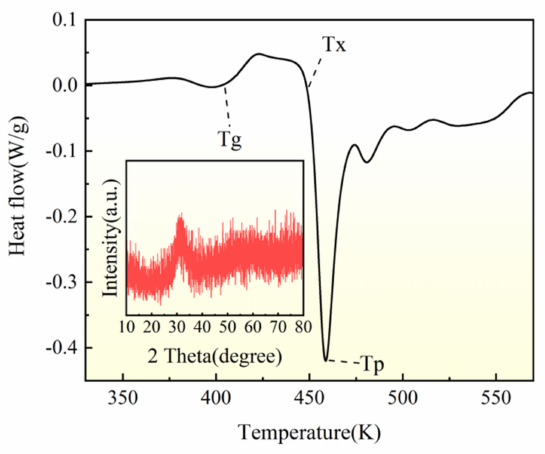
Figure 2. DSC curve and XRD pattern of La 65 Al 14 Ni 5 Co 5 Cu 9.2 Ag 1.8 BMG rod with a diameter of 5 mm. The inset is the X-ray diffraction